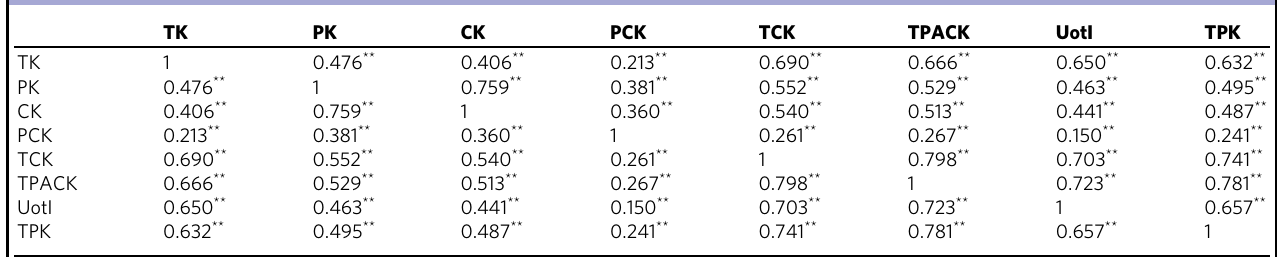
Table 5 Correlation between TPACK – UotI scales.